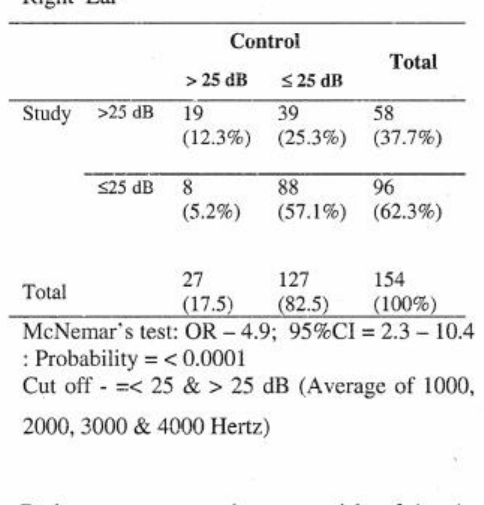
Control >25dB <25dB